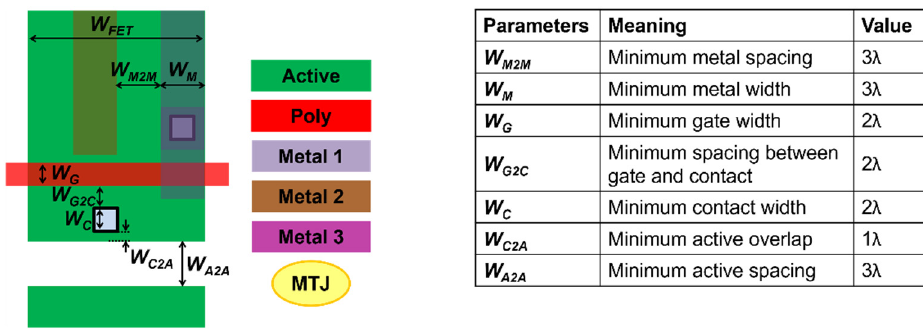
Figure 9. Single-port STT-MRAM layout ( a ) when the access transistor width is smaller than 9 λ , ( b ) when its access transistor width is greater than 9 λ , conventional 1R/1W STT-MRAM layout ( c ) when width of both transistors is smaller than 9 λ , ( d ) when width of either of M1 and M2 is greater than 9 λ , proposed 1R/1W STT-MRAM layout ( e ) when width of both transistors is smaller than 6 λ , ( f ) when width of either of M1 and M2 is greater than 6 λ . 𝑊 (cid:3007)(cid:3006)(cid:3021) (cid:3397) 𝑊 (cid:3002)(cid:2870)(cid:3002) (cid:3404) 𝑊 (cid:3007)(cid:3006)(cid:3021) (cid:3397) 3λ .